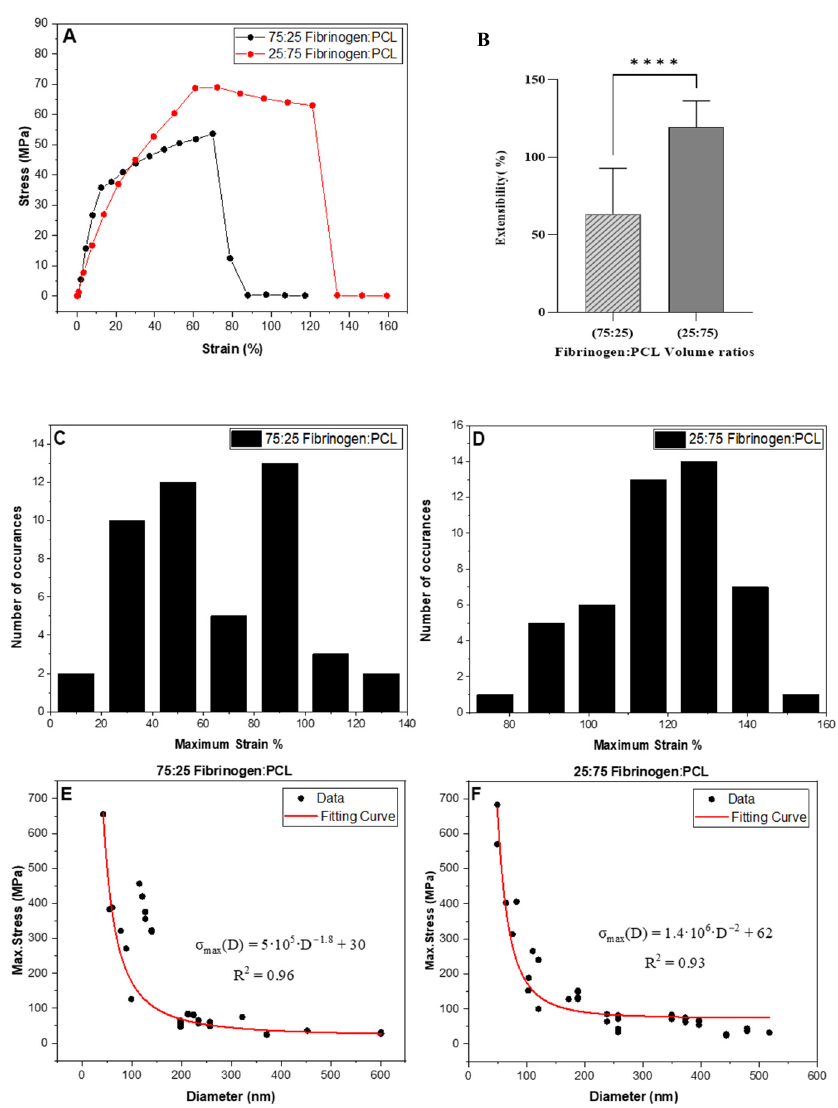
Figure 2. ( A ) Representative stress–strain curves of electrospun fibers showing strain softening. ( B ) Average extensibility of 75:25 and 25:75 fibrinogen:PCL fibers; 63 ± 29% and 120 ± 17%, respectively. They are statistically significantly different (unpaired t -test, p < 0.0001 (****), N = 47). ( C , D ) Histograms showing the maximum strain of blended fibrinogen:PCL nanofibers; ( C ) 75:25 ( N = 47); ( D ) 25:75 ( N = 47). ( E , F ) Maximum stress (breaking stress) of blended fibrinogen:PCL fibers as function of fiber diameter. The data were fit with a power law function σ max ( D ) = a · D − b + c , where σ max is the maximum stress, D is the fiber diameter and a , b , c are fitting parameters. The 75:25 fibrinogen:PCL fibers exhibited a linear slope until 12% strain (the yield point); then, the slope decreased significantly, and the fiber broke at 69% strain. The Young’s modulus decreased from 351 MPa (initial slope) at a strain of 10% to around 15 MPa (final slope) at